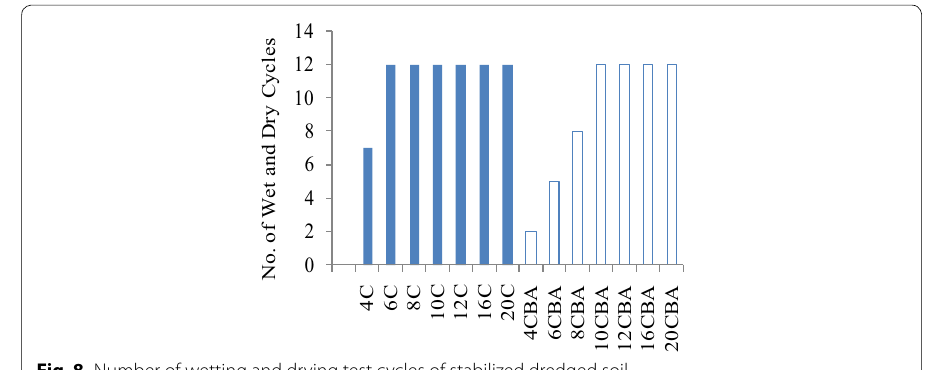
Fig. 8 Number of wetting and drying test cycles of stabilized dredged soil